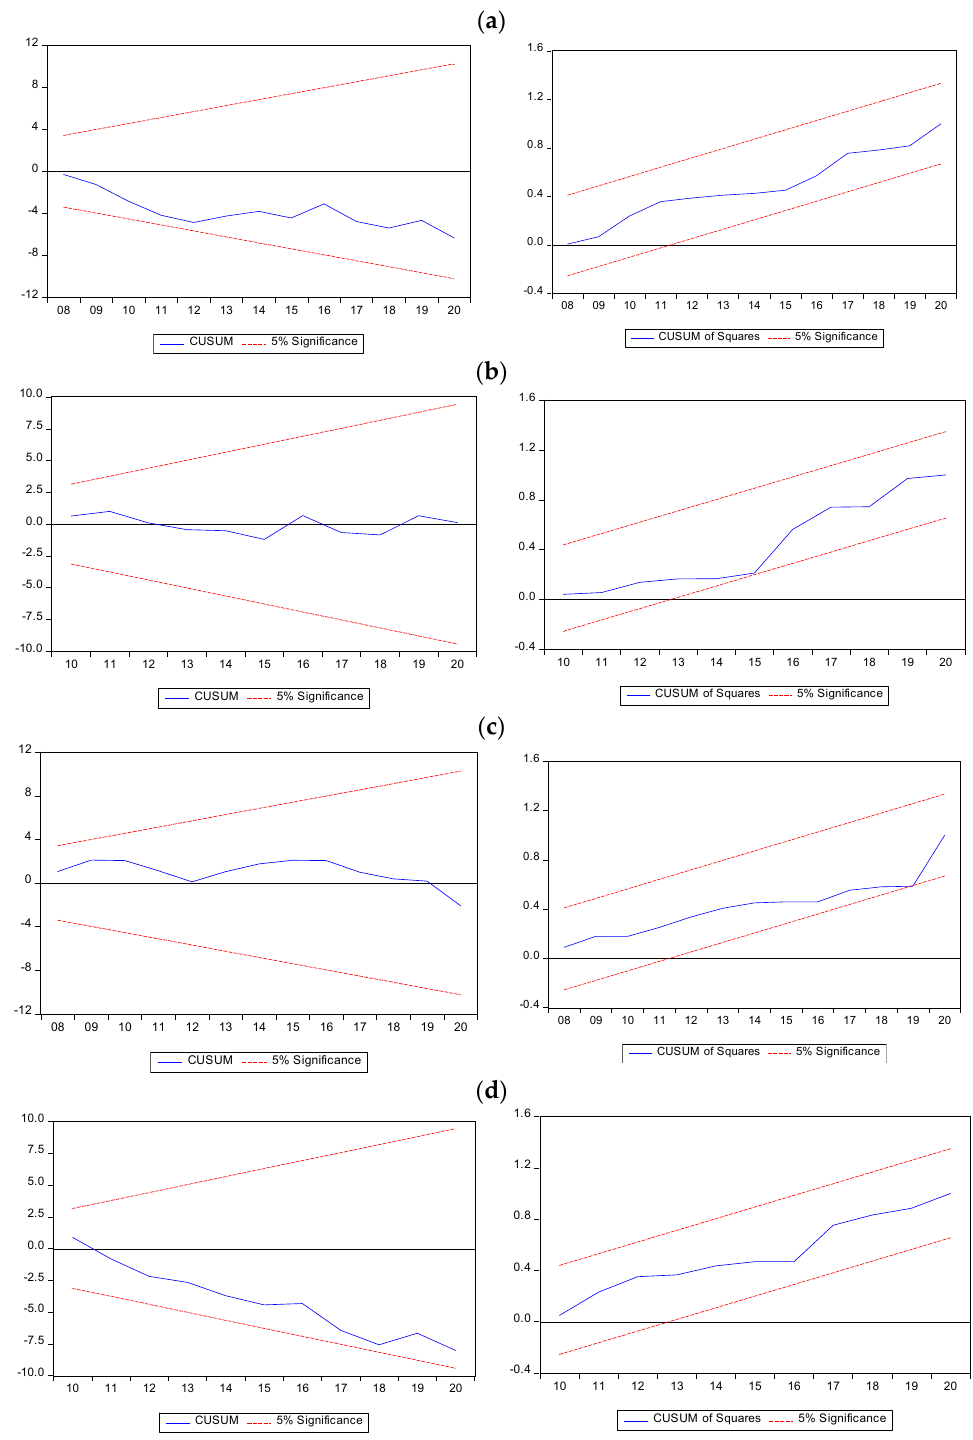
Figure 2. Results of the CUSUM and CUSUMSQ tests. ( a ) ARDL 1 ( BM , period 1990–2020); ( b ) ARDL 2 ( BM , period 1995–2020); ( c ) ARDL3 ( CREDIT , period 1990–2020); ( d ) ARDL 4 ( CREDIT , 1995–2020).